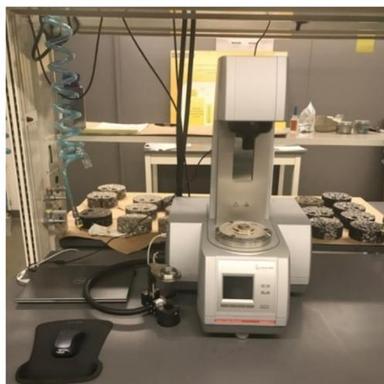
SmartPave 102 Anton Paar DSR machine in MAPIL.